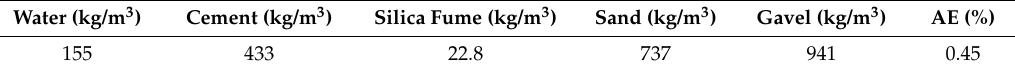
Figure 5. Geometric information of the test specimen. Table 2. Mix proportion of test concrete.